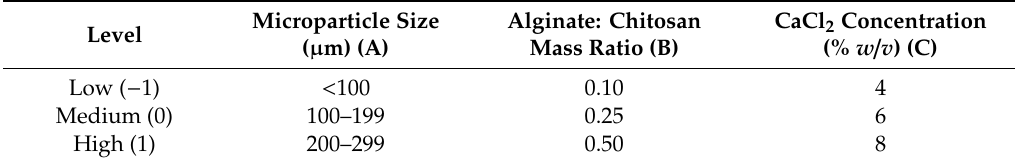
Table 1. Levels of the independent variables.